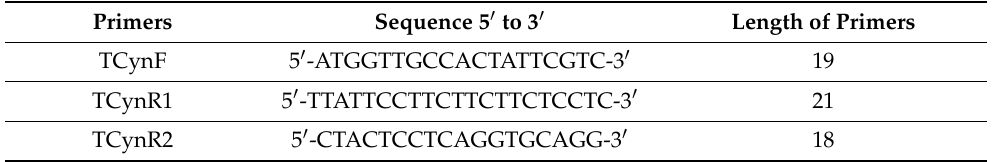
Table 6. Sequence and length of